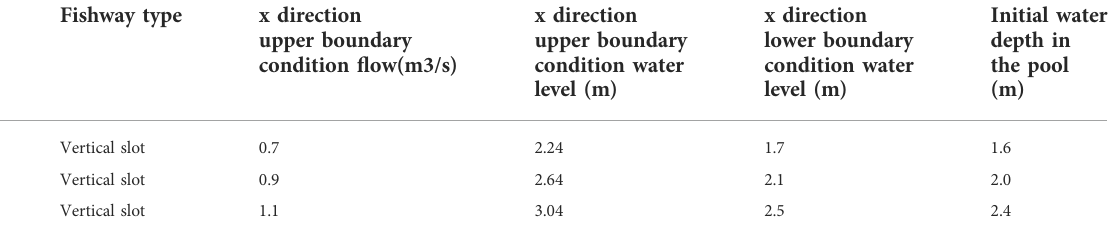
TABLE 2 Scenario design of vertical slot fi shway numerical simulation.